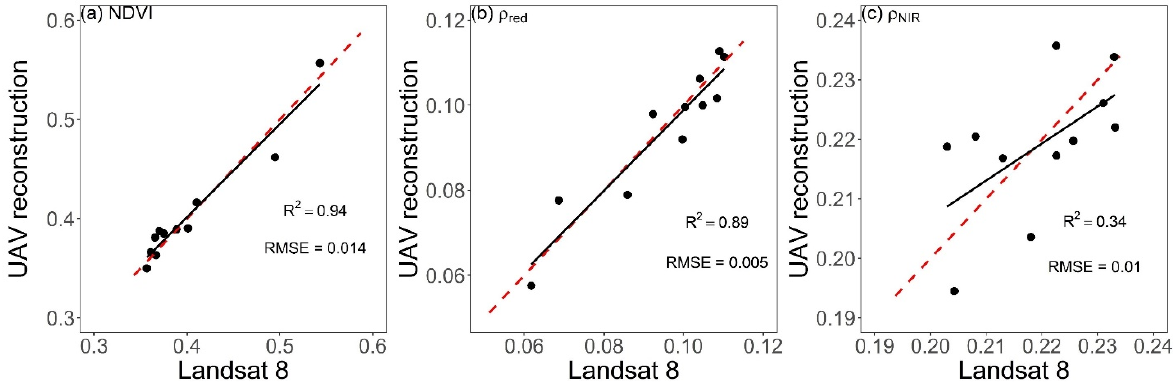
Figure 6. The correlations between Landsat 8 and UAV-reconstructed ( a ) NDVI, ( b ) red reflectance, and ( c ) NIR reflectance over the same Landsat 8 pixels. The UAV-reconstructed data were calculated using the linear correlation (Equation (3)) and the UAV-measured fractions and reflectance values. The dots represent the UAV and Landsat 8 data for the same week. The black line indicates the linear regression of the correlation, and the red dashed line is the 1:1 line.